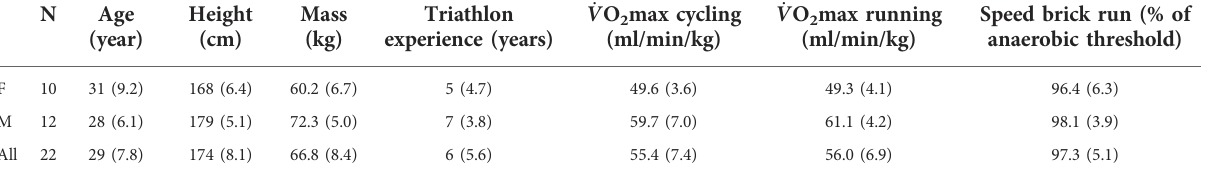
TABLE 1 Participant overview (F=female, M=Male, All=both, provided as mean (SD)).